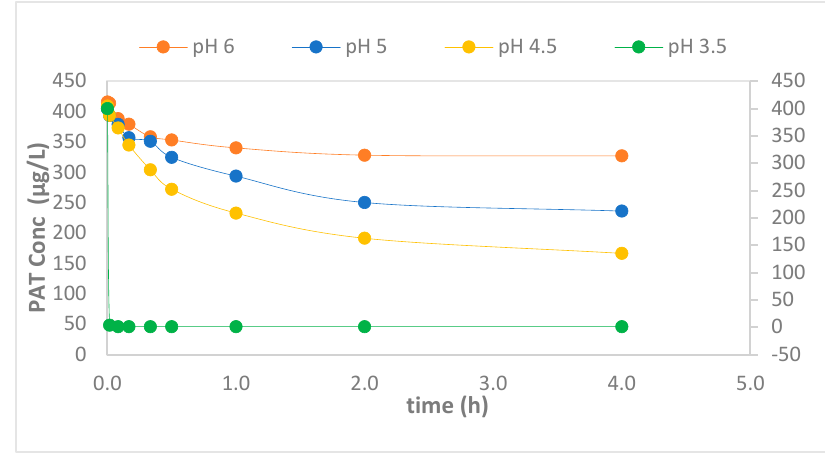
Figure 3. pH effect on heterogeneous Fenton reaction of CE-nZVI/H 2 O 2 . Figure 3. pH e ff ect on heterogeneous Fenton reaction of CE-nZVI / H 2 O 2